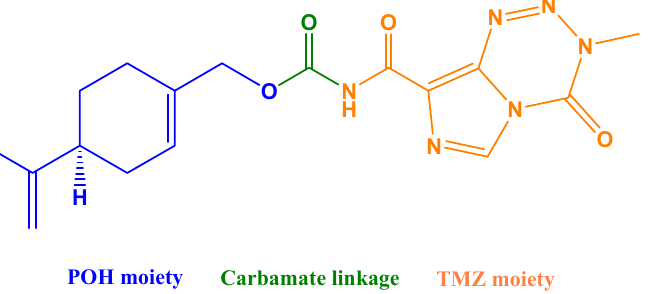
Figure 4. Chemical structure of a TMZ–POH conjugate (NEO212). NEO212 was generated by cova- lent conjugation of POH (perillyl alcohol; blue ) to TMZ (temozolomide; orange ) via a carbamate linkage ( green ).